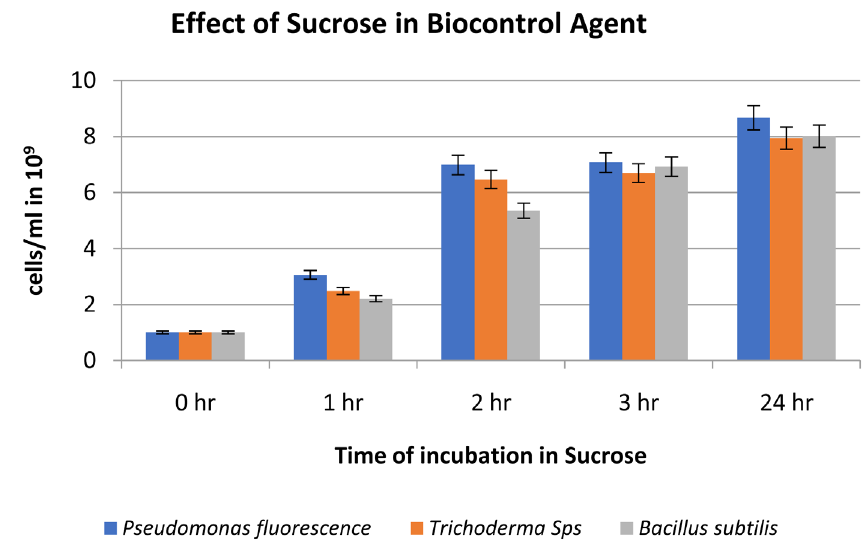
Figure 4. Effect of sucrose on the growth of Pseudomonas fluorescens , Trichoderma spp. and Bacillus subtilis . An increase in a number of cells of biocontrol agents was seen over time when these agents were kept in 5% (w/v) sucrose solution (n=3). The error bar represents the 5% error in independently performed experiments. The complete data are available in data availability section of this manuscript.